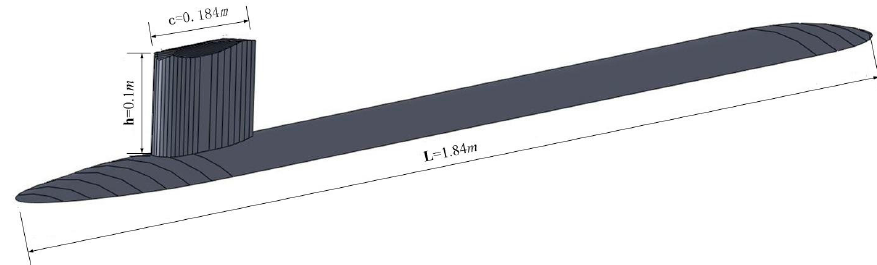
Figure 1. Diagram of the model. The model is the sail hull with part of the submarine body, which is scaled from the SUBOFF model. The length ( L ), and the height ( h ) of the sail hull are 1.84 m, and 0.1 m, respectively. The chord length ( c ) is 0.184 m.